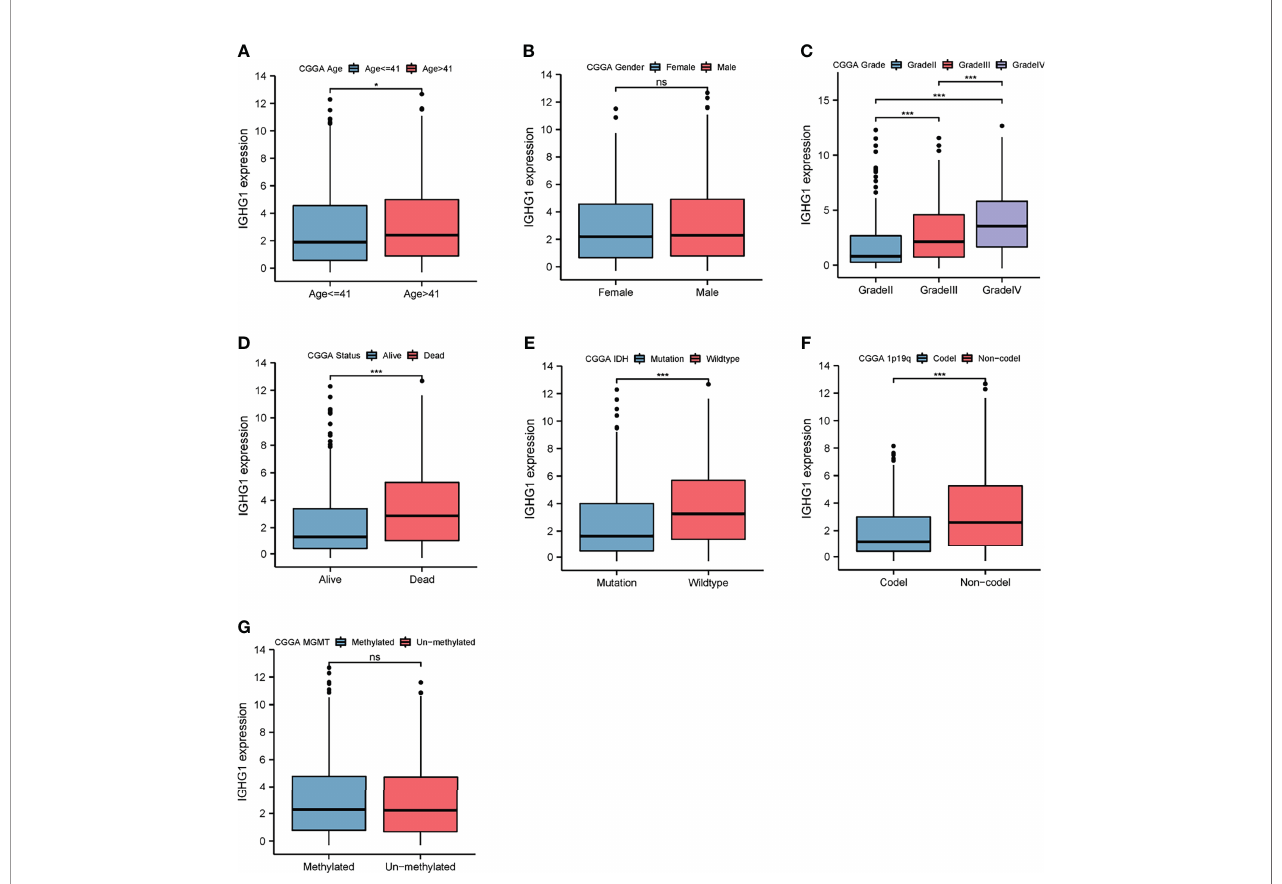
FIGURE 2 | Differences in the expression of IGHG1 among the different clinical characteristics in patients with glioma. Expression of IGHG1 in different ages (A) , genders (B) , grades (C) , living state (D) , isocitrate dehydrogenase (IDH) status (E) , 1p19q status (F) , and O 6 -methylguanine-DNA methyltransferase (MGMT) status (G) . * represent P < 0.01. *** represent P < 0.0001 and ns, represent no signi fi